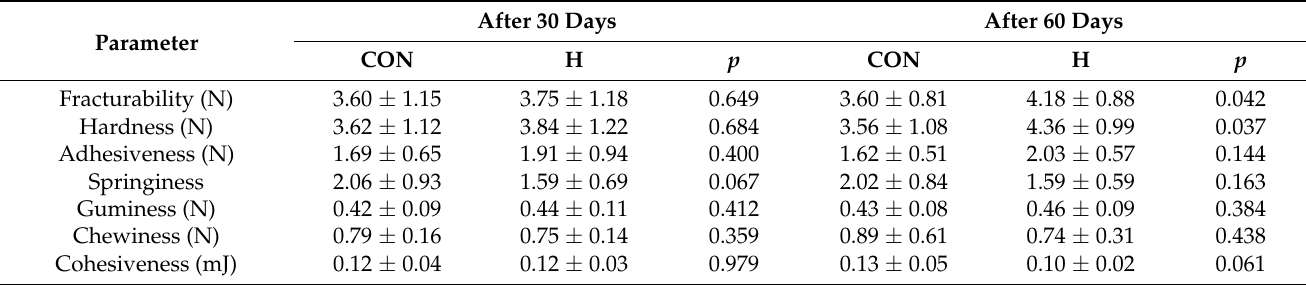
Table 4. Effect of the addition of oxyhumolite to the diet on rennet curd texture parameters (Mean ± SD). After 30 Days After 60 Days Parameter CON H p